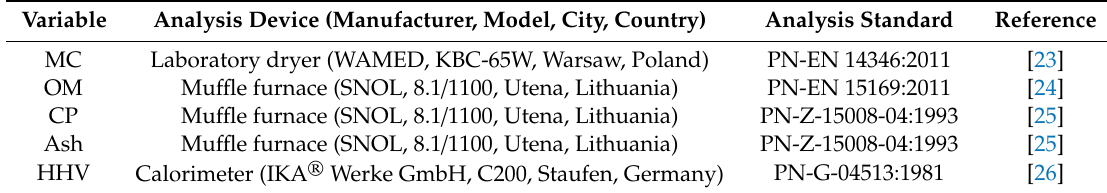
Table 1. Proximate analysis list and standard